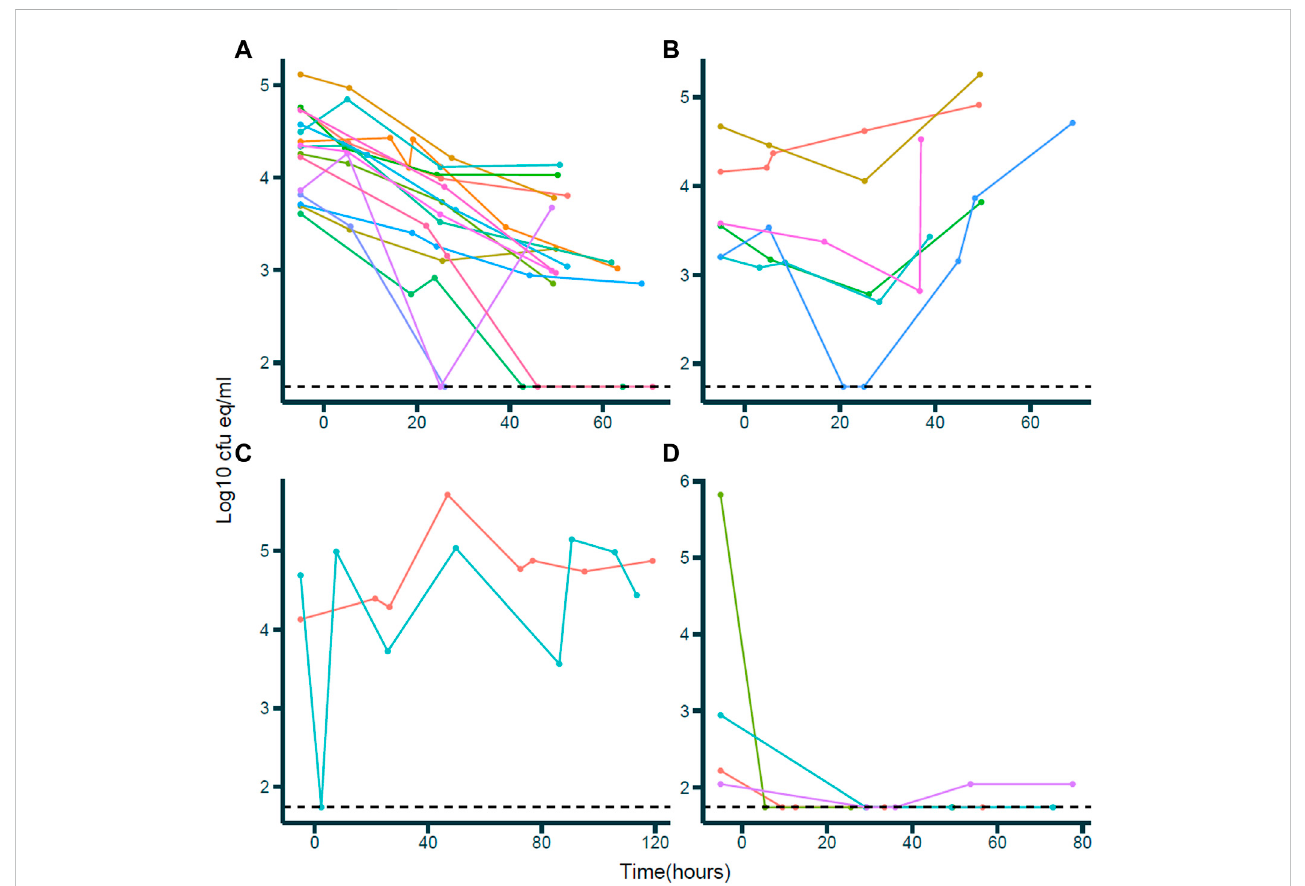
FIGURE 1 Bacterial DNA load (BDL)-time pro fi les during vancomycin treatment. X -axis: time in hours; Y -axis: BDL in log10 cfu eq/mL. Dots and lines of the same color within a plot indicate observations for individual patients. (A) Bactericidal responses; individuals demonstrating a negative trend in BDL over time. (B) Persisting septic responses; individuals demonstrating a constant or increasing trend in BDL over time. (C) Erratic responses; individuals demonstrating an erratic BDL over time following no speci fi c pattern. (D) Unquanti fi able response; individuals with very low BDL and BDL below quanti fi cation limit since vancomycin